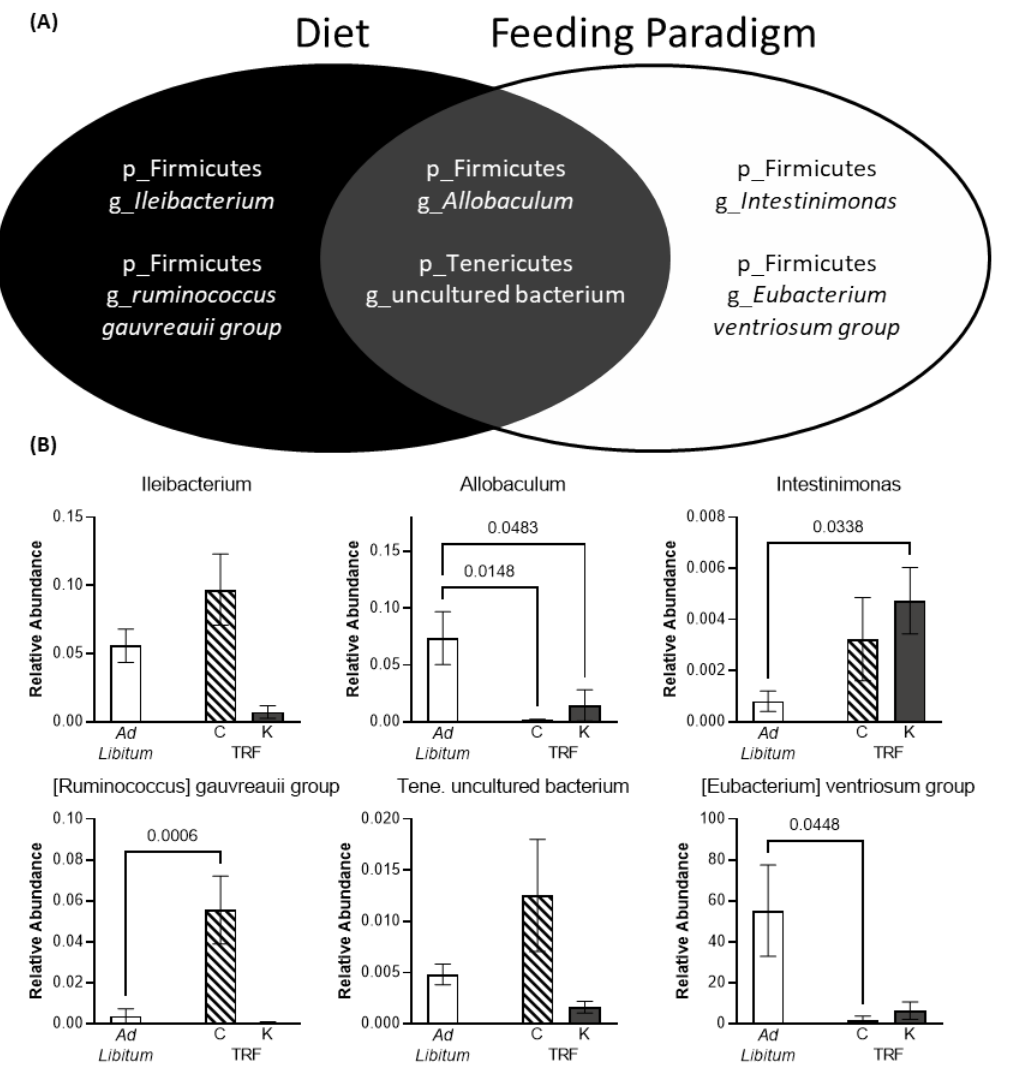
Figure 6. Significantly altered genera identified utilizing the analysis of composition of microbiomes (ANCOM) methodology. ( A ) 6 genera were identified to be significantly different across the different diet and/or feeding paradigm groups. ( B ) Relative abundance of the identified genera. All data are group means ± 1 SEM.